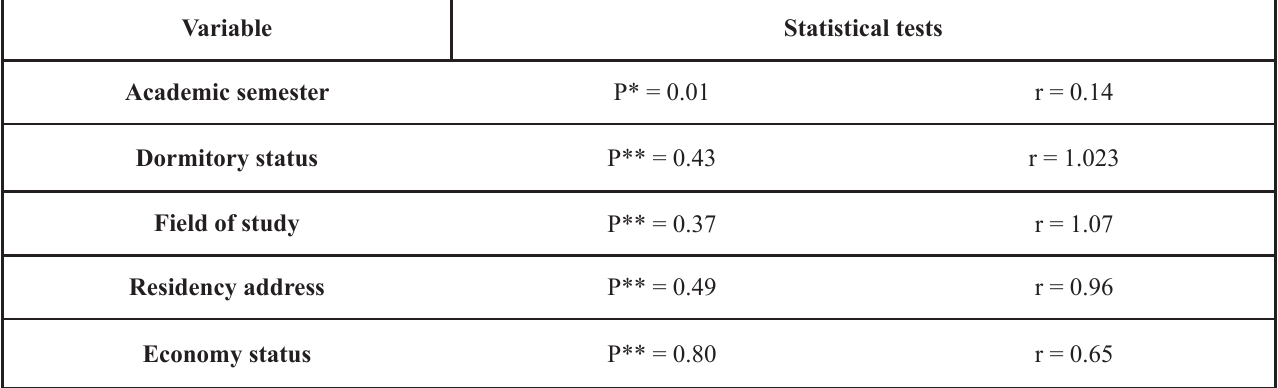
Table 4: Relationship between sleep quality and some socioeconomic characteristics